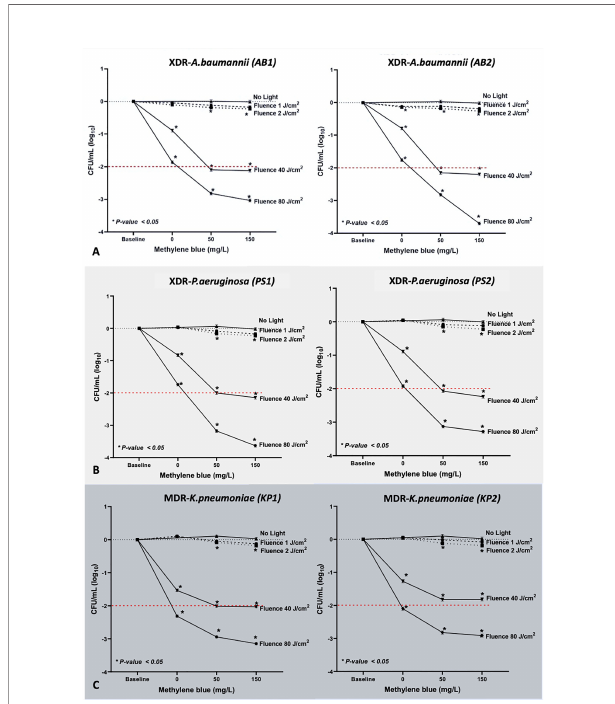
FIGURE 3 | Results of MB-aPDT on (A) XDR- AB1 and AB2, (B) XDR-PS 1 and PS2, and (C) MDR- KP1 and KP2, with the light doses of 1, 2, 40, and 80 J/cm 2 (irradiance of 65 mW/cm 2 , irradiation time from 0.20 to 26.40 min; l max at 633 nm) and two MB concentrations were tested (50 and 150 mg/L). The values demonstrated were the means of triplicate measurements. *Statistically signi fi cant difference (p-value